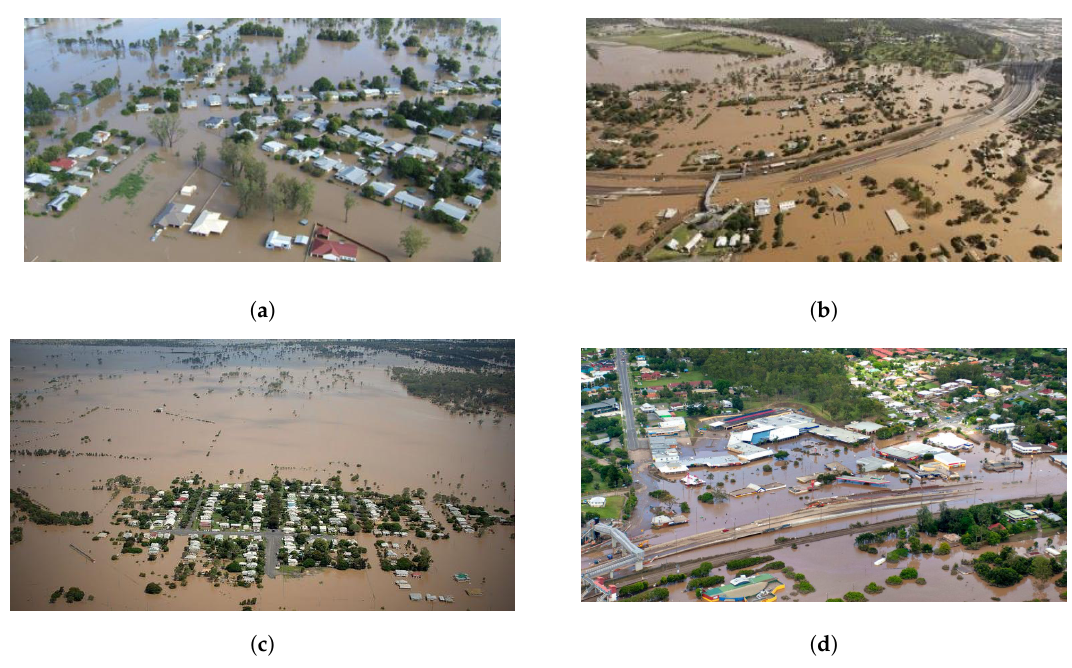
Figure 3. Aerial Images from different sources showing different flood affected regions of Queensland and NSW Flood, 2011. ( a ) Southern Queensland town of Theodore during 2011 floods [38]. Photo was taken by Jackie Jewell; ( b ) State Library of Queensland during 2011 floods [39]; ( c ) Lockyer Valley Region, Queensland, Australia during 2011 floods [40]; ( d ) Brisbane River flooding at Goodna during 2011 floods